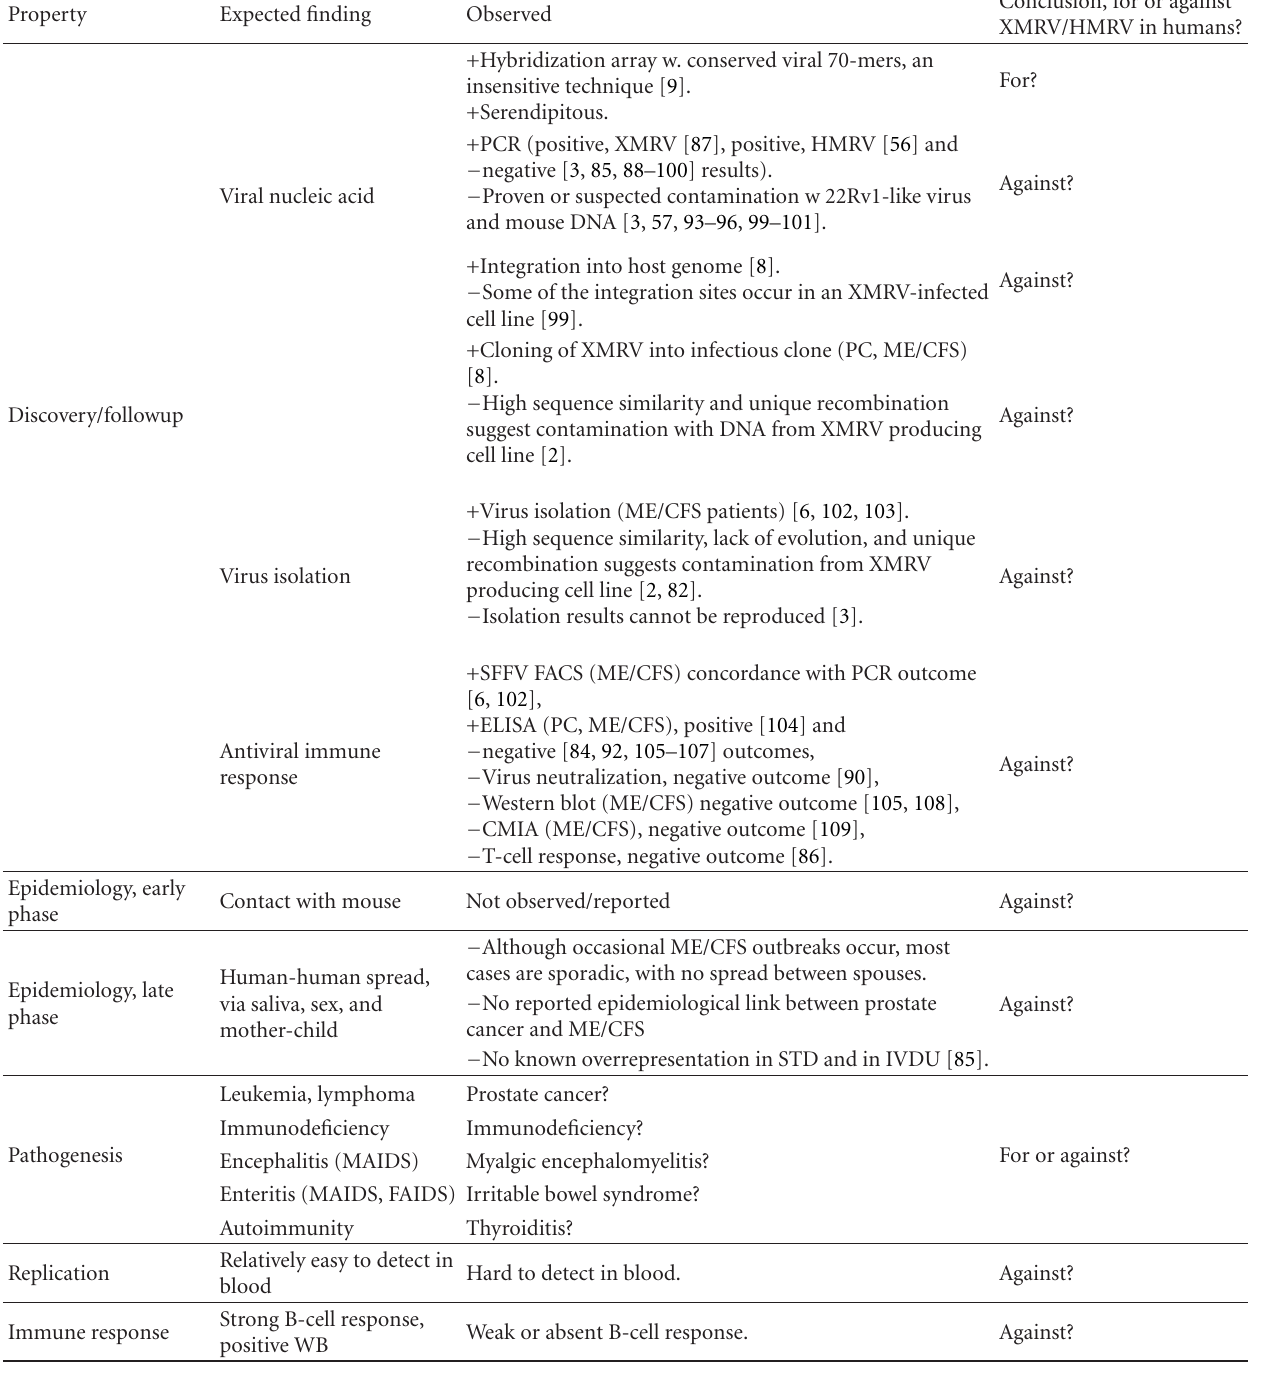
Table 1: How well does XMRV/HMRV fulfill the expected properties of an MLV spread to humans + means an argument for, and—an argument against